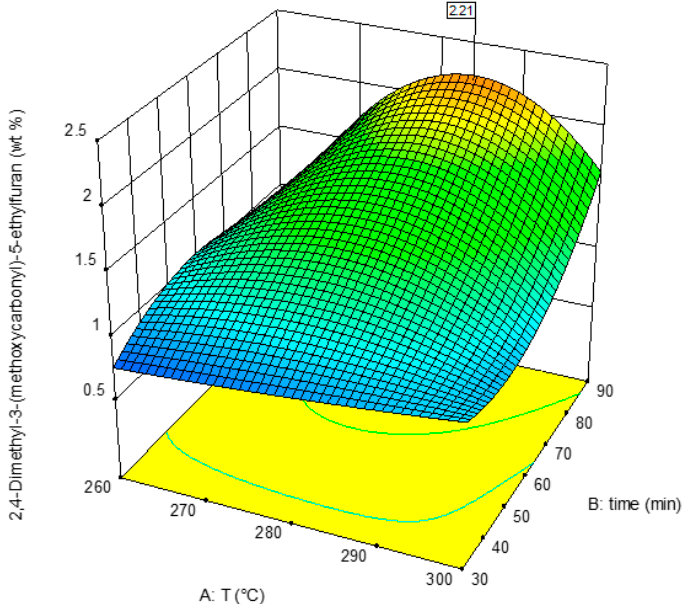
Figure 6. Prediction of the 2,4-dimethyl-3-(methoxycarbonyl)-5-ethylfuran production at different conditions of temperature and residence